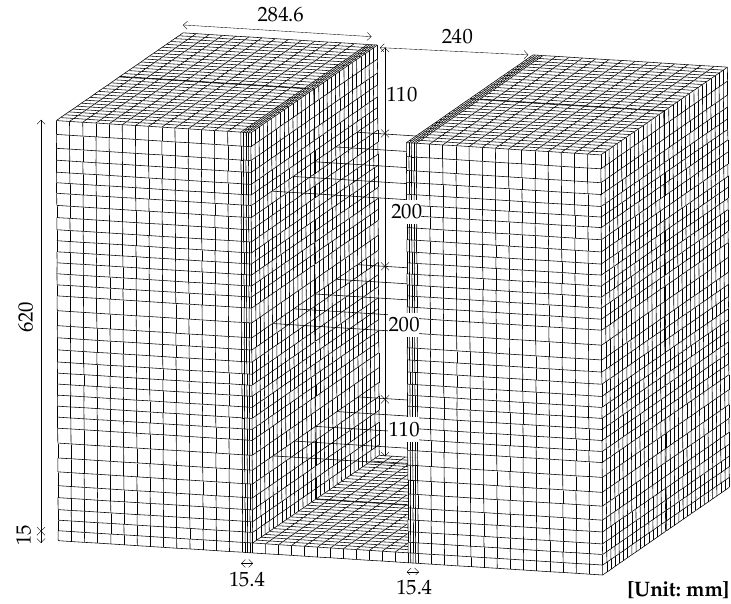
Figure 4. Three-dimensional mesh of the numerical